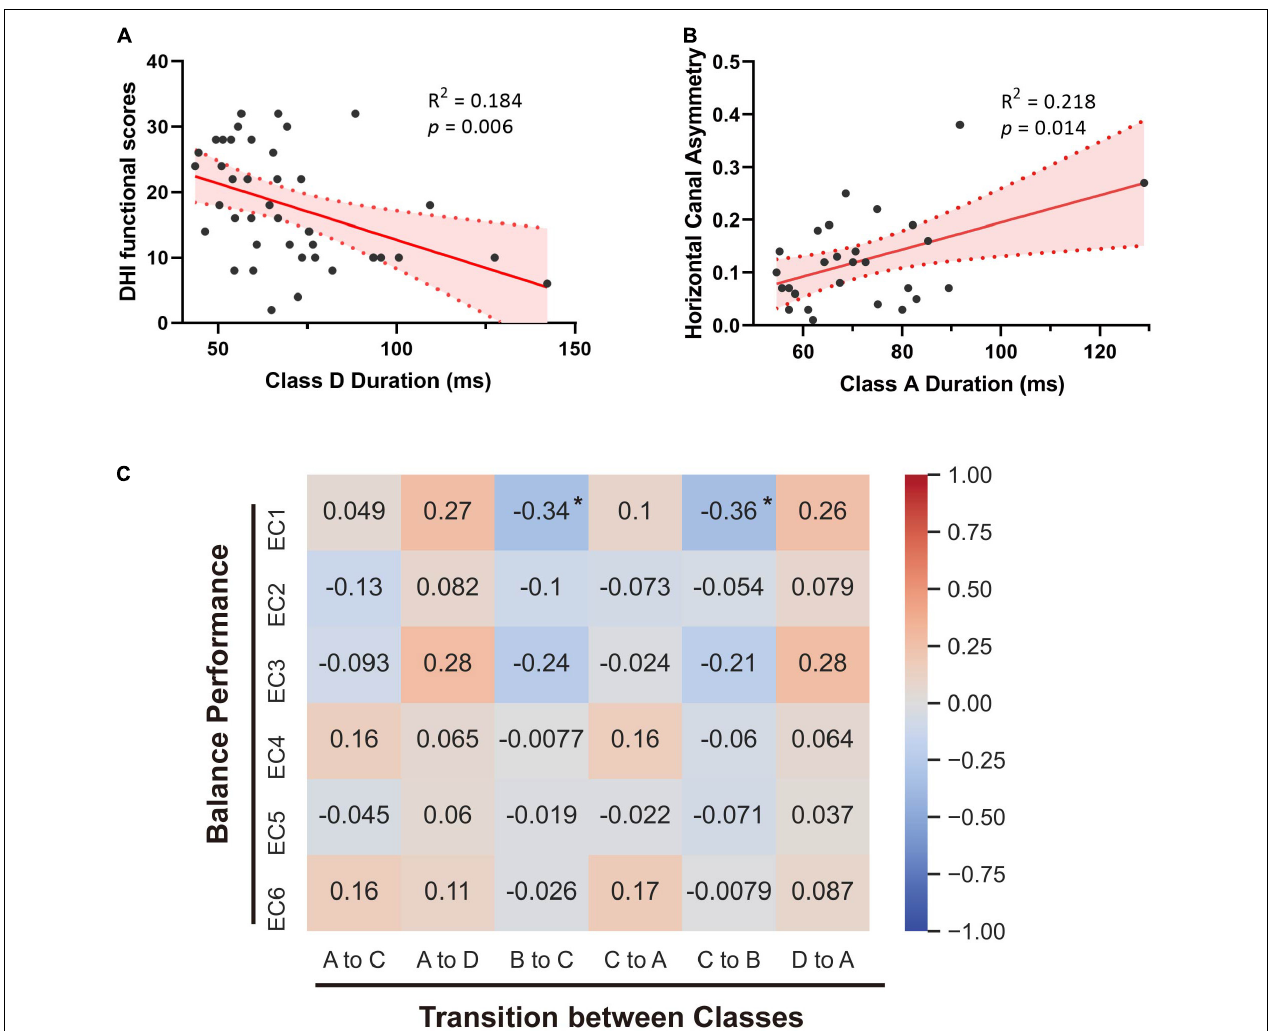
FIGURE 3 | Correlations between microstates and clinical parameters. (A) Linear regression analysis of Class D duration and the functional handicaps measured by DHI. (B) Linear correlation between Class A duration and the asymmetry of horizontal semicircular canal gains. (C) Spearman’s correlations between microstates’ transitions and balance performance of patients with vertigo. Spearman R values are marked. * p <